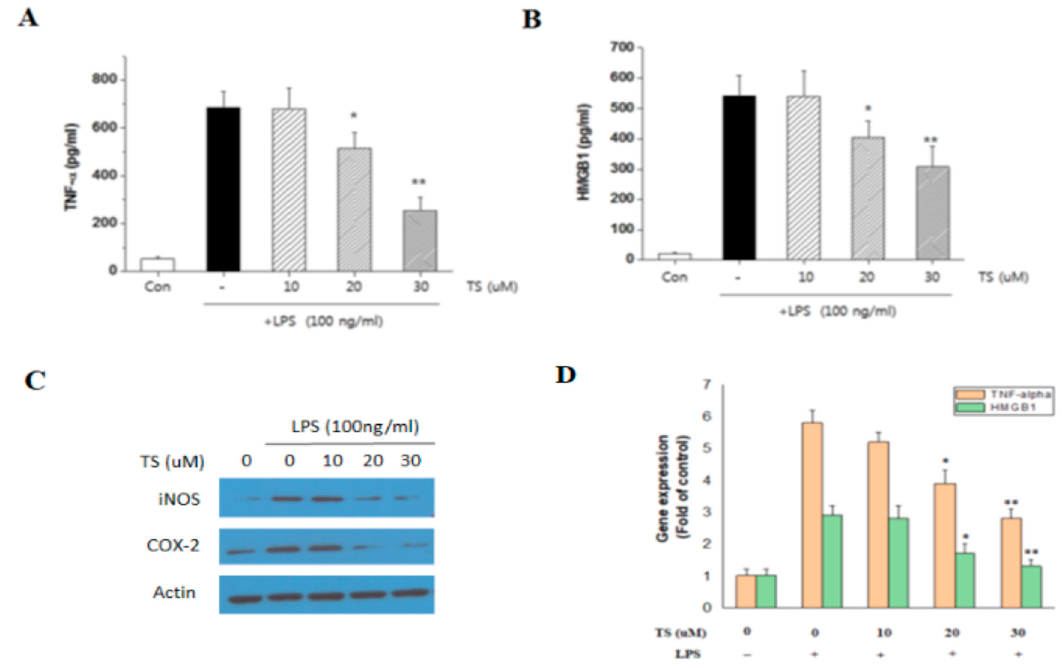
Figure 3. Effect of TS on tumor necrosis factor-alpha (TNF- α ) and high-mobility group box 1 (HMGB1) expression in an LPS-stimulated macrophage cell line. RAW 264.7 cells were pretreated with TS at the indicated concentrations for 1 h and then stimulated with LPS (100 ng/mL) for 24 h. The culture medium was collected and subjected to ELISA to measure the concentration of TNF- α ( A ) and HMGB1 ( B ); Cells were also harvested and lysed for western blot ( C ) and quantitative real-time PCR ( D ) analysis to determine expression of TNF- α and HMGB1. * p < 0.05, ** p < 0.01 vs. LPS-treated sample. All experiments were performed in triplicate. Con: control. − : no treatment; +: